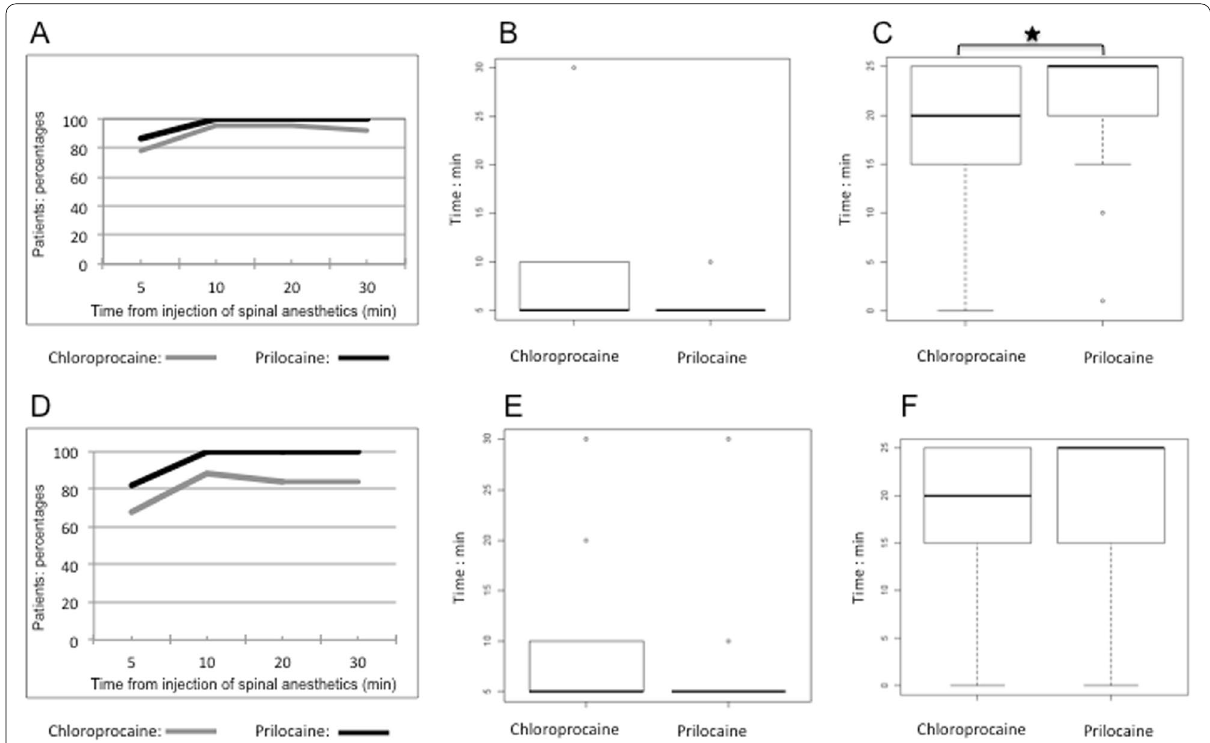
Fig. 2 a Percentage of patients with a complete loss of cold sensation at the T12 dermatome during the first 30 min after local anesthetics injection. b Time to obtain a T12 dermatome level extension of sensory block evaluated with cold test. c Duration of sensory block at T12 dermatome level evaluated with cold test. d Percentage of patients with negative pin-prick test at T12 dermatome level during the first 30 min after local anesthetics injection. e Time to obtain a T12 dermatome level extension of sensory block evaluated with pin-prick test. f Duration of sensory block at T12 dermatome level evaluated with pin-prick test. Statistically significant differences are marked with *( P <